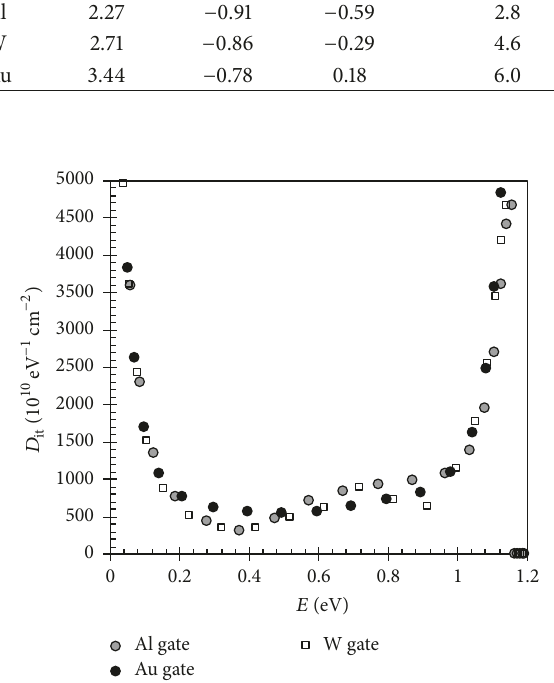
Figure 19: Interface state density versus energy over the entire Si